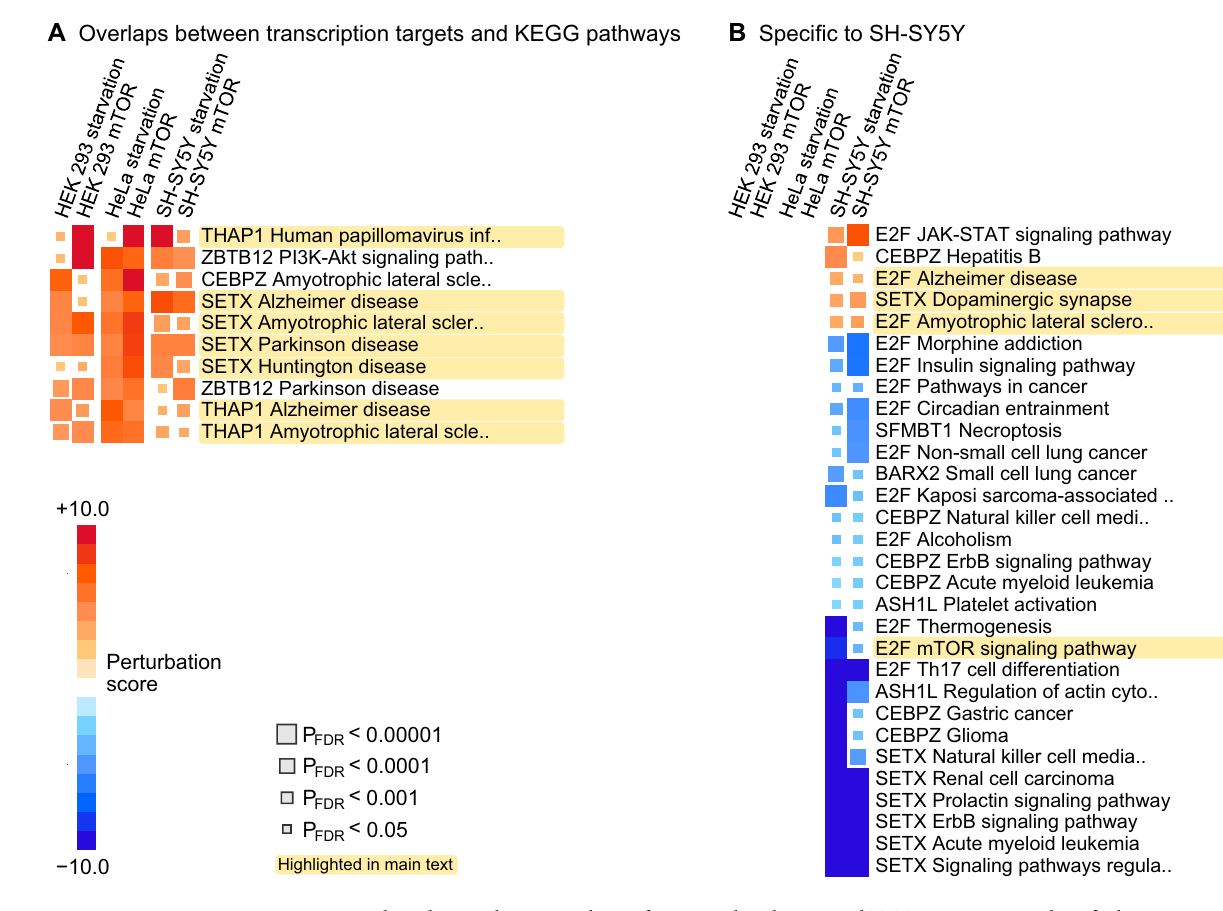
Figure 5. Combined perturbation analysis of canonical pathways and TFT sets. First, we identified DE genes that were shared between a KEGG pathway and TFT sets. Then, we used Signaling Pathway Impact analyses to test if the shared genes would impact the activity of the KEGG pathway. Therefore, the perturbation scores are predictions on the potential regulatory effects differentially expressed transcription factor target genes will have on canonical pathways. ( A ) TFT-pathway pairs that showed directionally consistent and significant (P FDR < 0.05) perturbation scores across every experiment. ( B ) TFT-pathway pairs that showed directionally consistent and significant (P FDR < 0.05) perturbation scores in the two experiments on SH-SY5Y cells but no significant signals in other